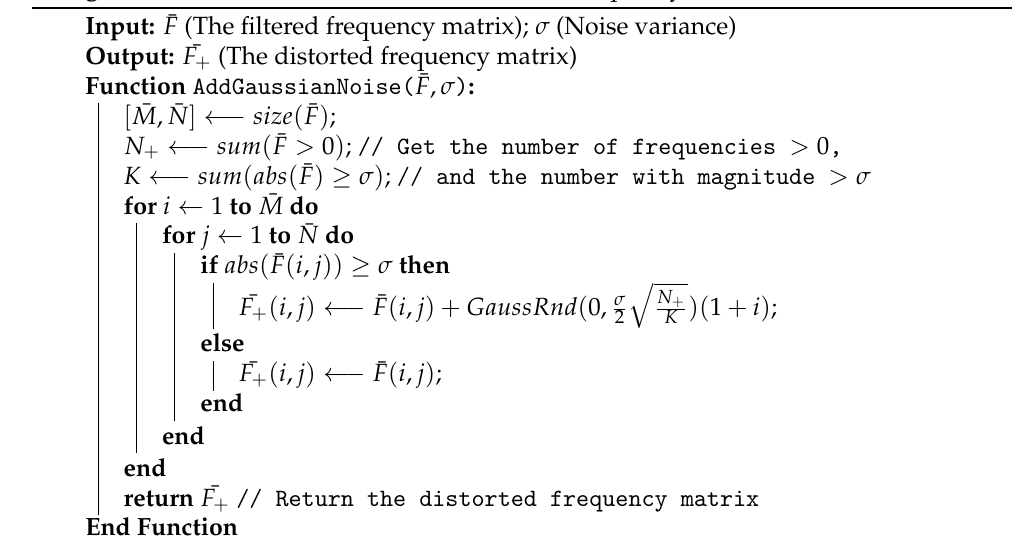
Algorithm 2: Add Gaussian white noise to the frequency